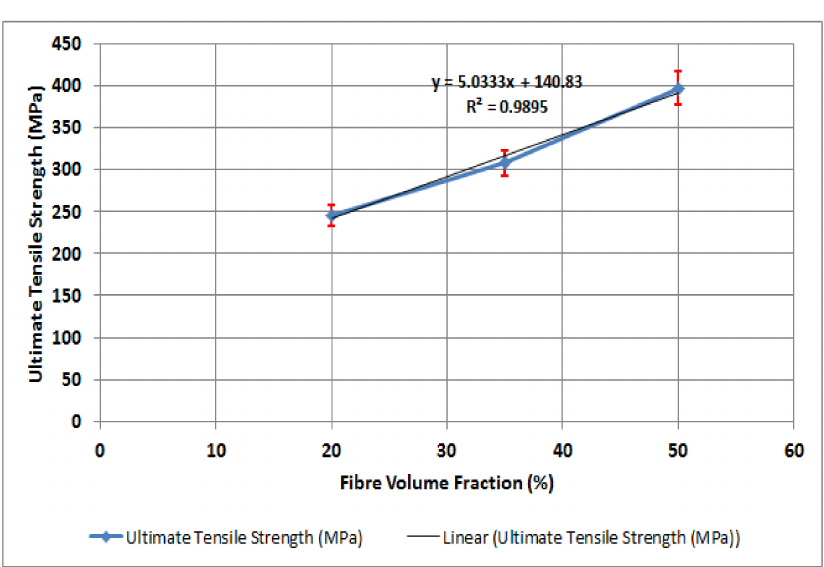
Figure 5. Ultimate tensile strength for polyester specimens reinforced with 20%, 35%, and 50% fibre volume